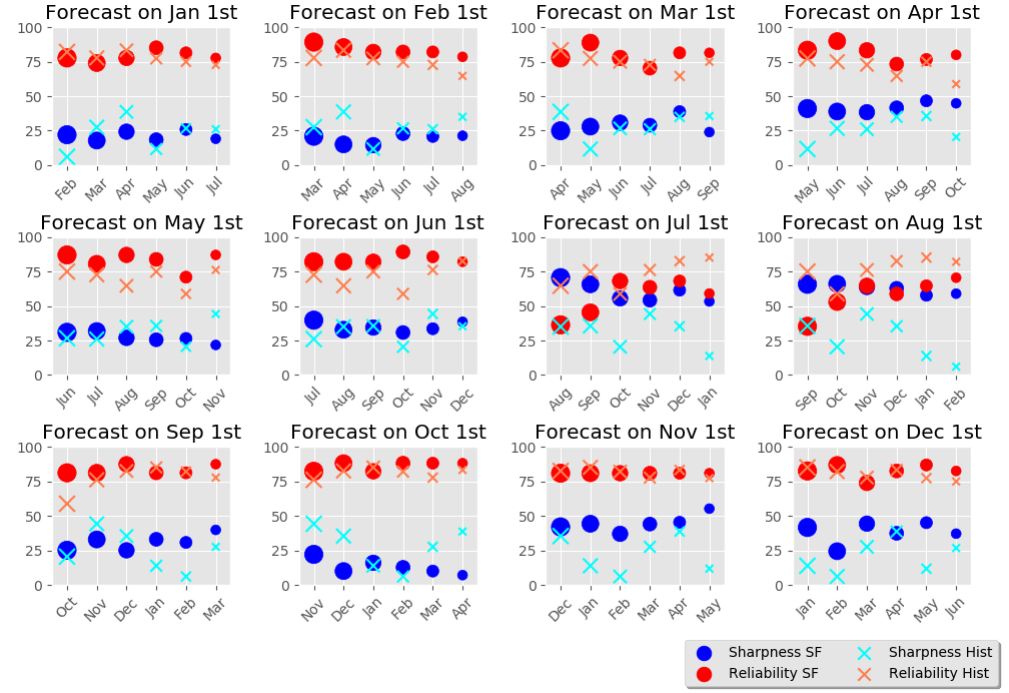
Figure 7. Reliability and sharpness of the prediction for each month provided by the traditional method (crosses), and the climate services (CS) (circles) for the six horizons, for the study period 1981– 2015.